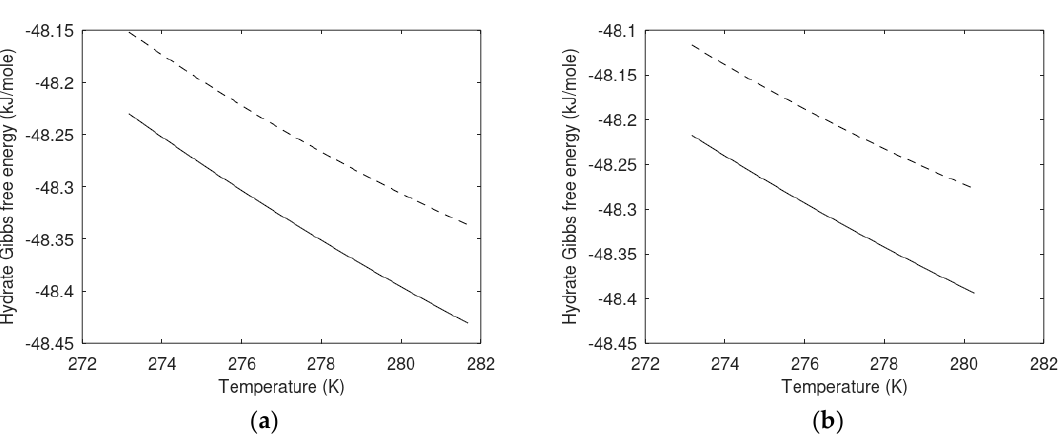
Figure 16. Hydrate Gibbs free energy for hydrate formed heterogeneously from CO 2 and liquid water (solid) and homo- geneously formed hydrate from dissolved CO 2 in water (dashed). ( a ) Pure water. ( b ) Water containing 3 mole percent ethanol.